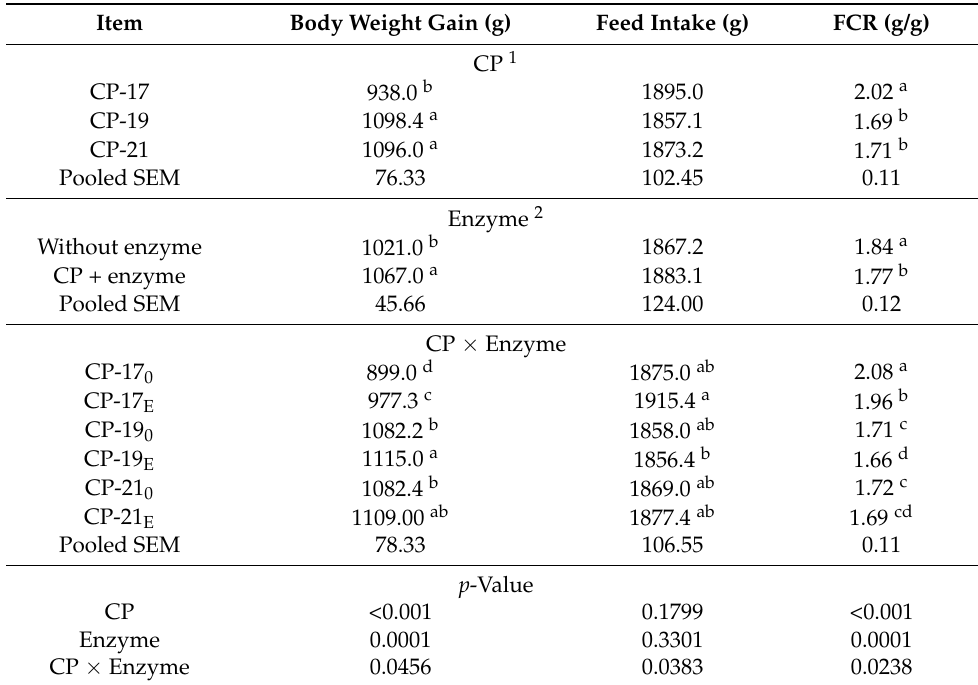
Table 2. Body weight gain, feed intake and feed conversion ratio (FCR) of broilers fed different levels of crude protein and protease enzyme over 15–28